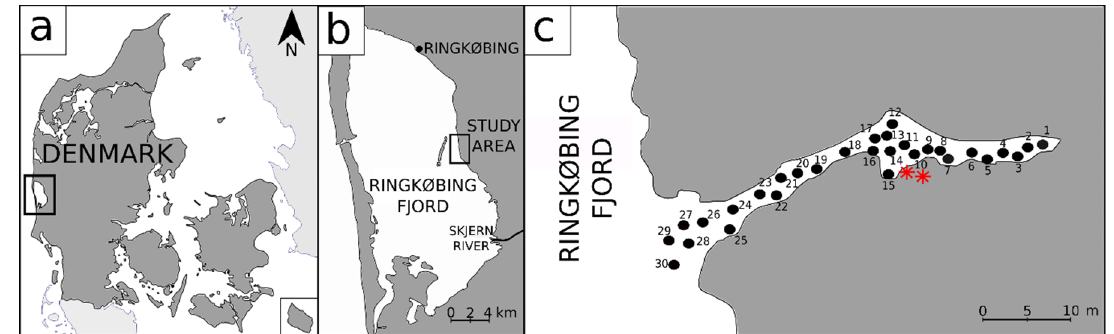
Figure 1. ( a ) The location of Ringkøbing Fjord, ( b ) the study area, the water depth in the lagoon is ~30–50 cm from the shore line and 2 km offshore to the elongated island, ( c ) The lagoon inlet. The black numbered dots indicate the location of the measuring points. The red stars indicate the location of the deep wells used to obtain the average annual groundwater temperature.